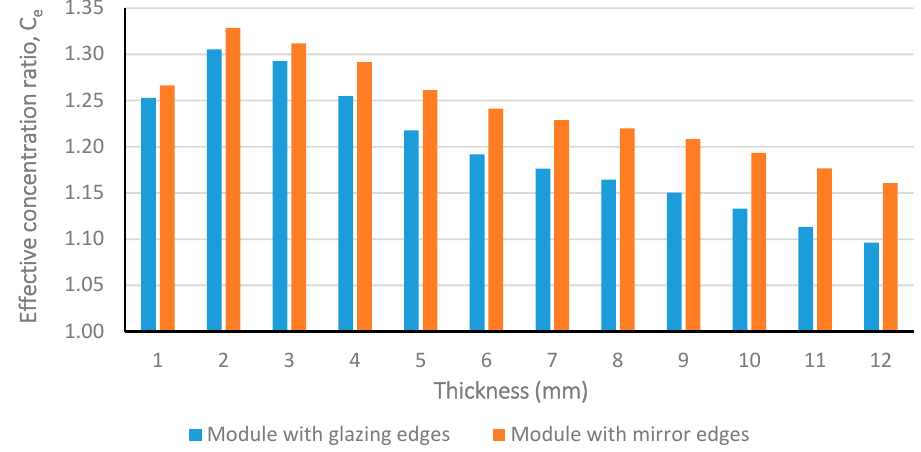
Figure 5. The effective concentration ratio as a function of glass thickness with and without edge mirrors.